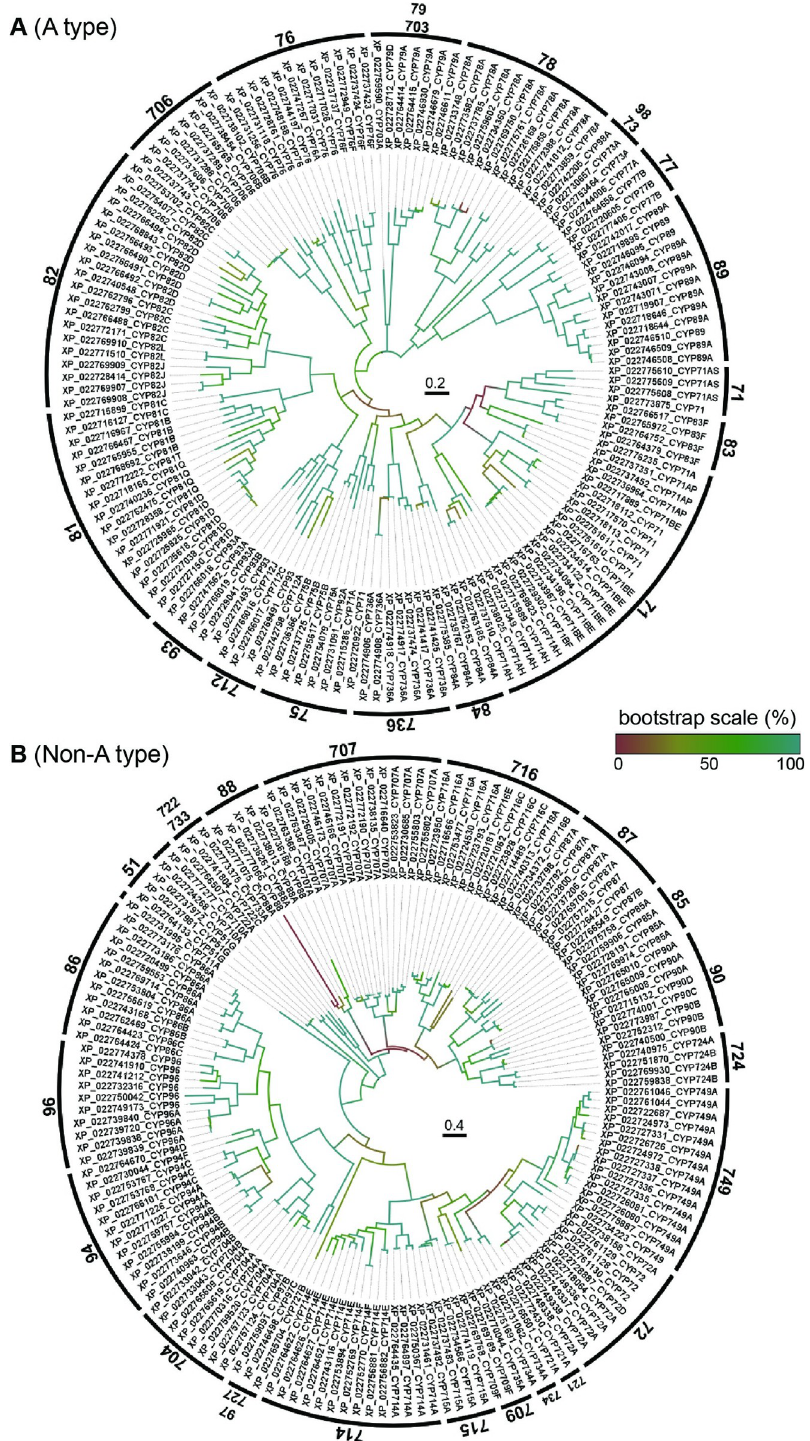
Fig 1. Phylogenic tree of durian cytochrome P450s. (A) A-type is represented by clan 71. (B) Non-A type is represented by the other families. The numbers on each clan indicate the family of cytochrome P450. The name of durian P450s is indicated by the protein accession number followed by the predicted (sub) family. The tree was constructed by the maximum likelihood method with 100 replicates. The colors on the trees indicate the bootstrap values (percentages) after 100 replicates. The scale bars in the circular trees represent the number of amino acid substitutions per site.